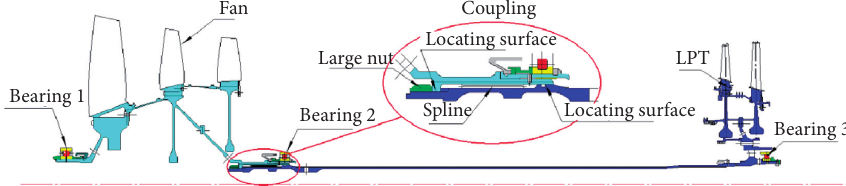
Figure 5: The coupling of an aero-engine dual-rotor-bearing system